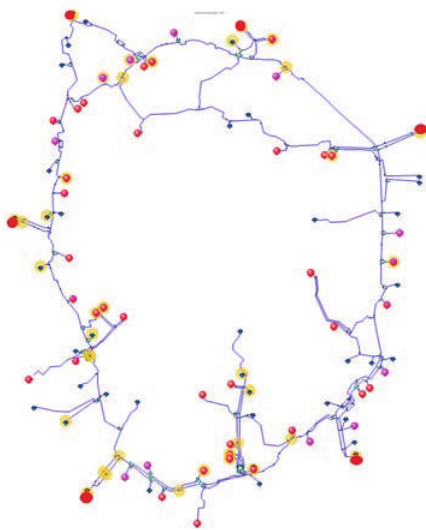
Figure 4: Example of IP distribution in the MRG model.